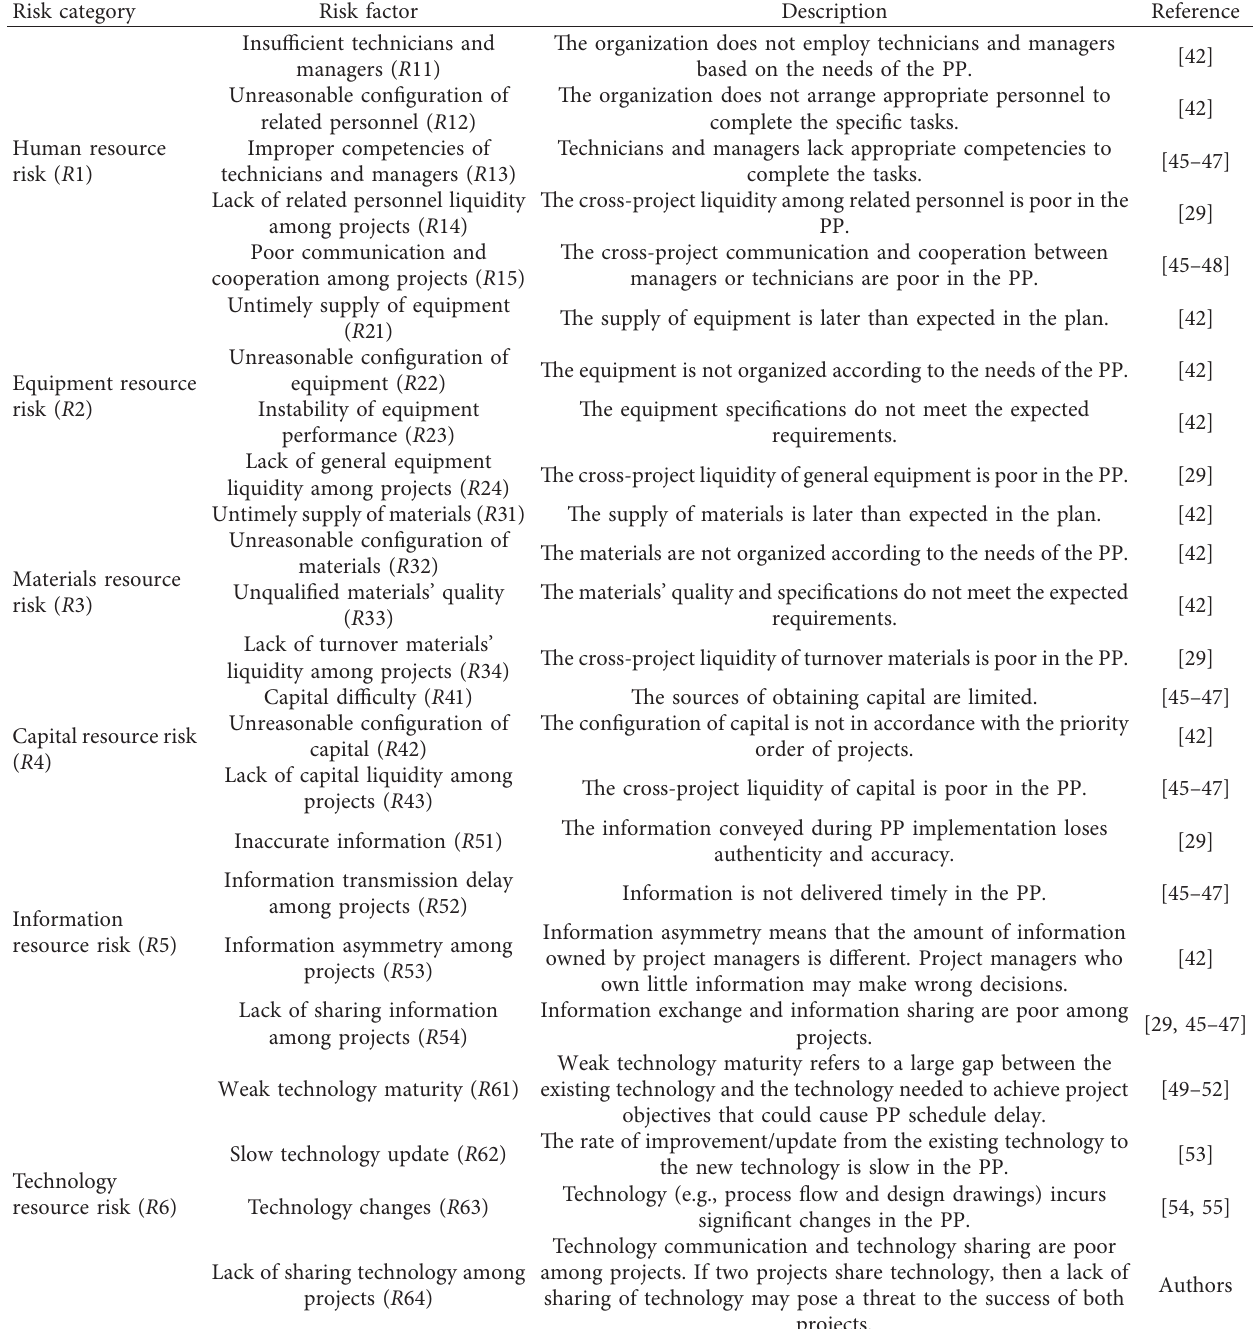
Table 2: Project portfolio resource risk factors.